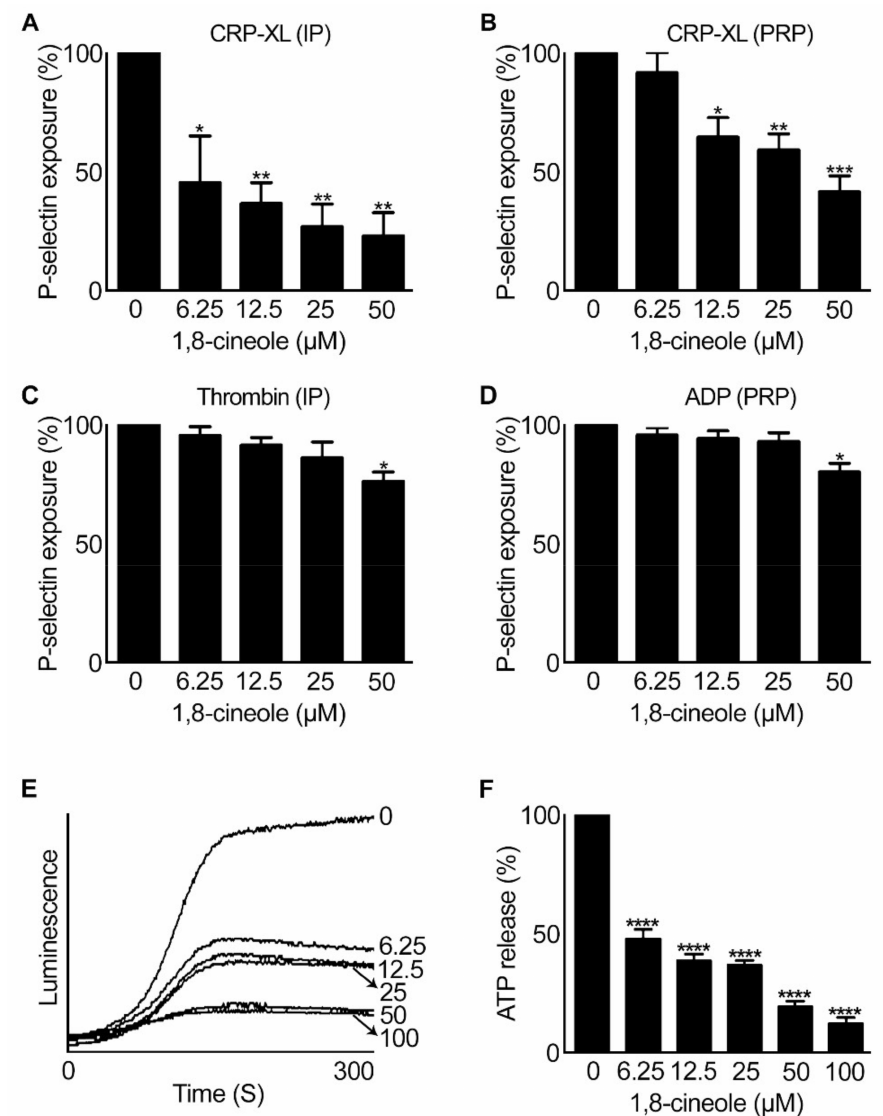
Figure 5. Impact of 1,8-cineole on granule secretion in human platelets. Human isolated platelets (IP) or PRP were incubated with a vehicle control [0.01% ( v/v ) ethanol] or various concentrations of 1,8-cineole for 5 min prior to the addition of CRP-XL (0.5 µ g/mL) ( A , B ), thrombin (0.025 U/mL) ( C ) or ADP (2.5 µ M) ( D ) and further incubation for 20 min at room temperature. The level of α -granule secretion in platelets was determined by quantifying the amount of P-selectin exposed (as a marker for α -granule secretion) on the platelet surface upon activation using PE/Cy5-conjugated anti-human P-selectin antibodies by flow cytometry. The bar graphs show the effects of various concentrations of 1,8-cineole on α -granule secretion in human isolated platelets or PRP upon stimulation with different agonists. Moreover, the effect of 1,8-cineole on dense granule secretion was quantified by measuring the level of ATP release upon activation of platelets. The human isolated platelets were incubated with different concentrations of 1,8-cineole or a vehicle control [0.01% ( v/v ) ethanol] for 5 min in the presence of the Chrono-lume luciferin-luciferase reagent and the level of ATP released upon platelet activation with 0.5 µ g/mL CRP-XL was monitored using lumi-aggregometry. The traces ( E ) shown are representative of four separate experiments. The cumulative data ( F ) shown demonstrate the effect of 1,8-cineole on dense granule secretion in platelets as calculated by considering the level of ATP release observed with the vehicle control as 100%. Data represent mean ± SEM. ( n = 4). The p values shown (* p < 0.05, ** p < 0.01, *** p < 0.001 and **** p < 0.0001) are as calculated by one-way ANOVA followed by Bonferroni post hoc